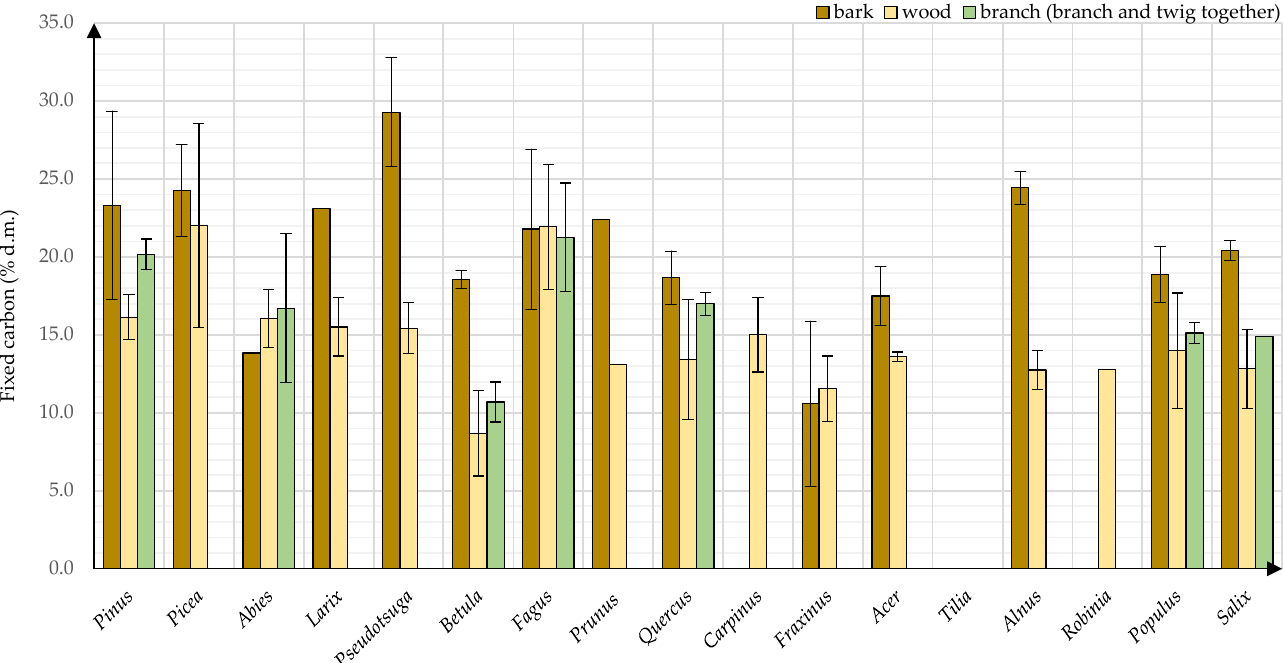
Figure A2. Average value and average deviation of the fixed carbon of organs of particular systematic genera trees.